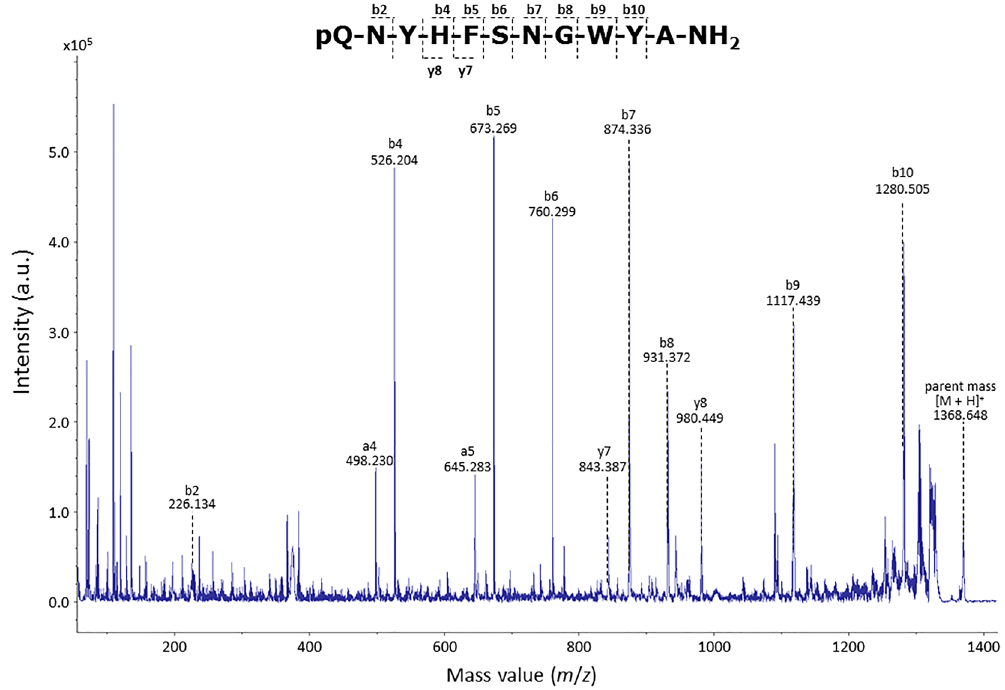
Figure 1. Identification of ly-GnRH/CRZ by mass spectrometry. MALDI-TOF/TOF MS/MS spectrum of ly-GnRH/CRZ. Parent ion [M + H] + , b-ions, y-ions, and a-ions of ly-GnRH/CRZ are labeled.